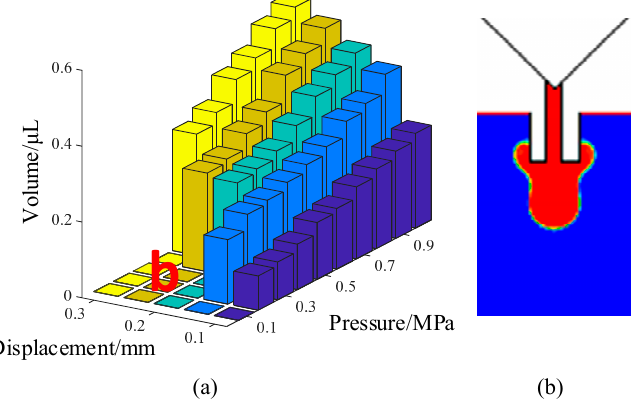
Figure 10. The influence of surface tension and viscosity on the volume of the droplet: ( a ) Jetting volume; ( b ) sputtering. Conditions: The nozzle diameter is 0.2 mm, the frequency is 20 Hz, and the needle displacement is 0.3 mm.